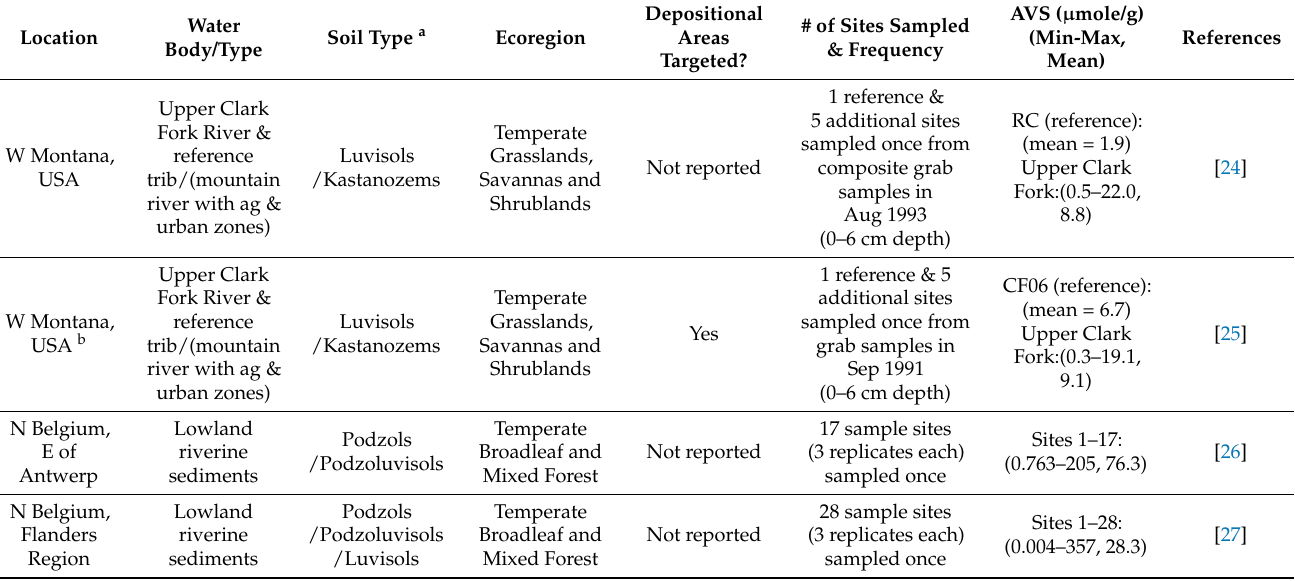
Table 2. Summary of historical acid-volatile sulfides (AVS) sediment data from rivers and